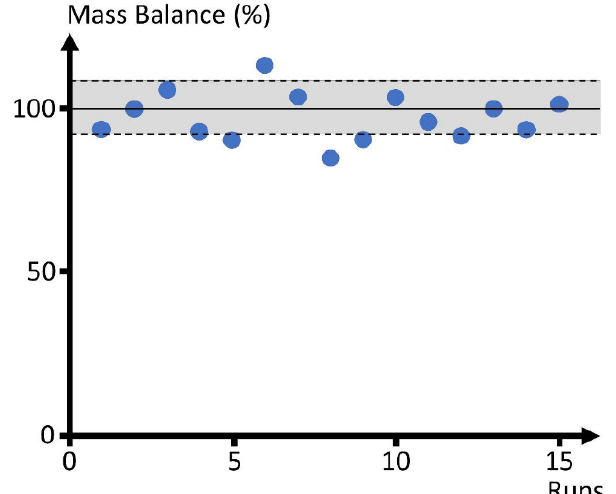
Figure A2. Hc1 % Mass Balances for 15 Catalytic Cracking Runs of 1, 3, 5-TIPB, Prior to Reactor Evacuation Using the Method Described in Appendix A: Condition 2, Standard Deviation: ±7.8%.